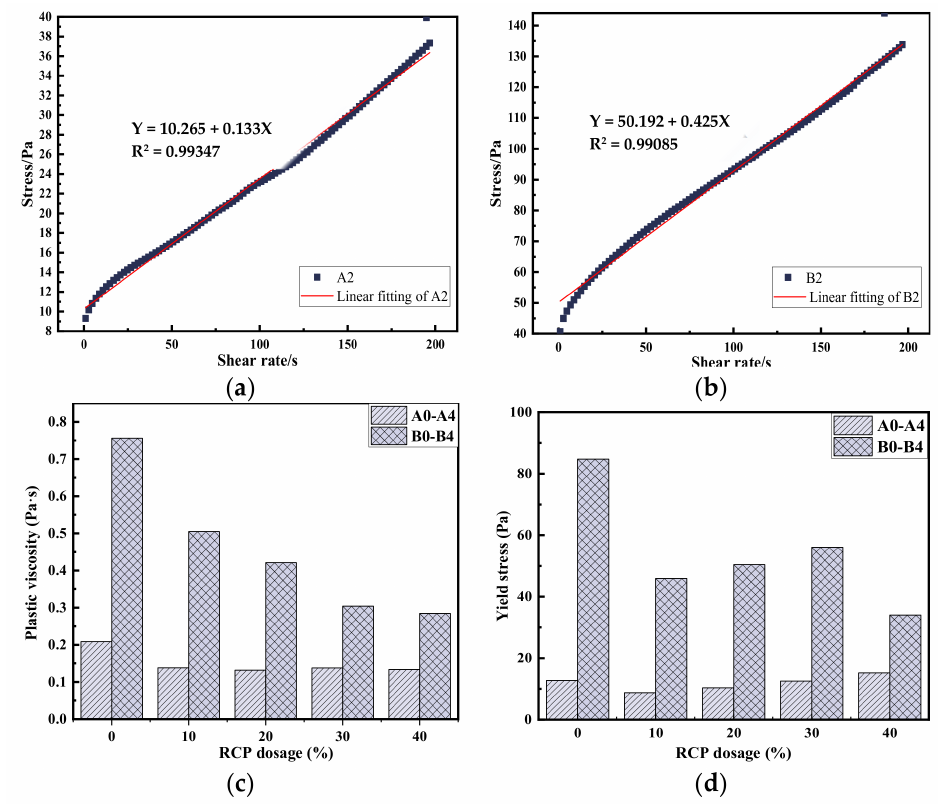
Figure 8. Influence of RCP content on the rheological properties of different systems. (( a ) Rhe- ological curve regression model of A2, ( b ) Rheological curve regression model of B2, ( c ) A0–A1 (Cement + RCP), ( d ) B0–B4 (Slag +